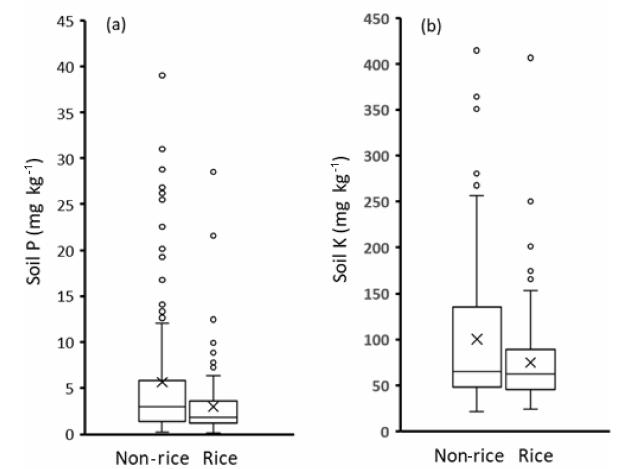
Figure 5. (a) Available P and (b) extractable K concentrations across seven watersheds.